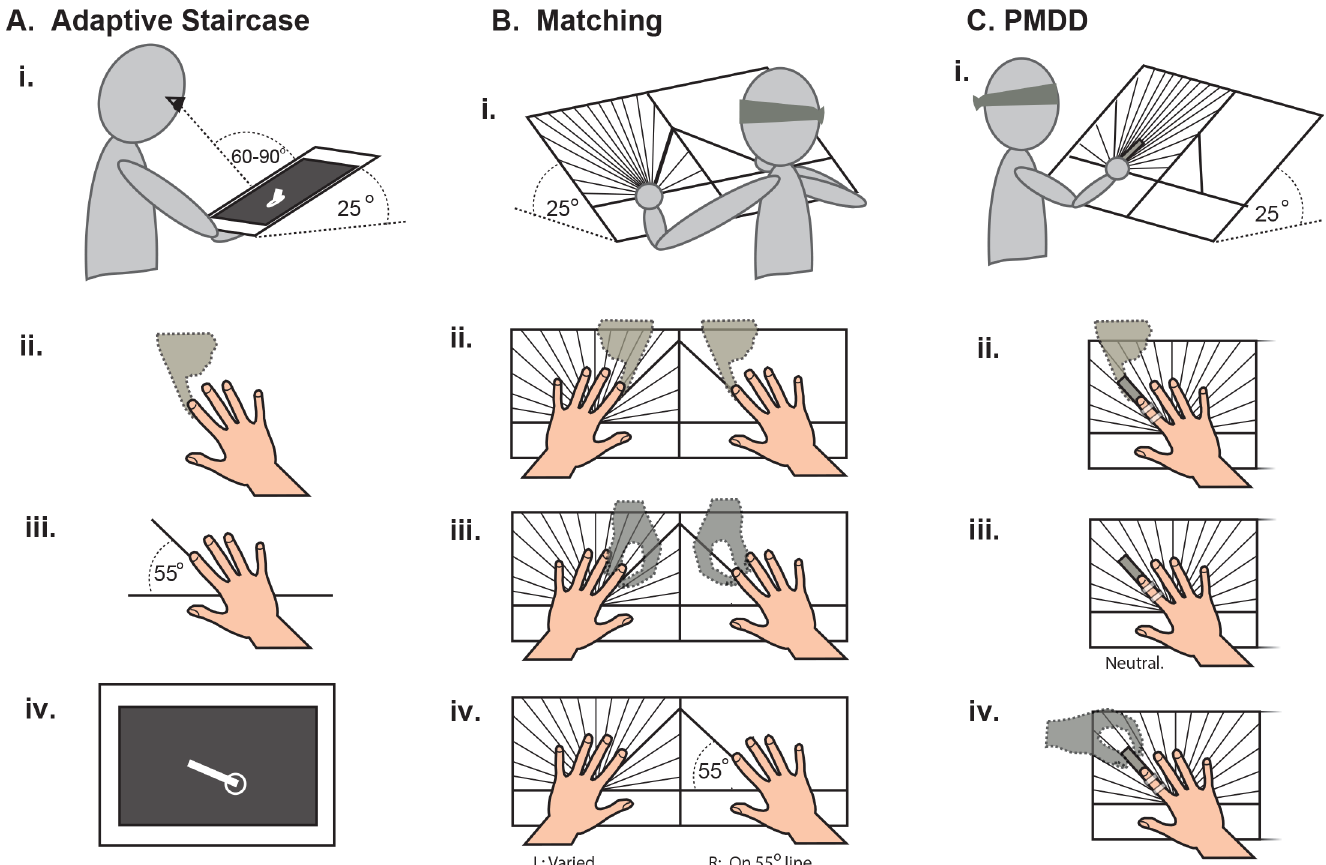
Fig 1. Setup procedures for each method. A. i . Subject positioning for the adaptive staircase method. Right hand placed on a 25° stand beneath the display screen. ii. The blindfolded subject was instructed to press firmly against the experimenter ’ s finger (dashed outline) and then relax to control for muscle thixotropy. iii. The hand was positioned in an outline drawn on the angled stand. The MP joint of the 2 nd finger was on a tactile marker with the index finger pointing along a 55° line and the other fingers slightly spread. iv. The display screen was placed over the subject ’ s hand and the blindfold removed. Subject was asked, “ Do you feel like the end of the white line is to the left or to the right of your index fingertip? ” B. i. Subject positioning for the matching method. Both hands placed in outlines on the angle board, inclined at 25°. Subject blindfolded throughout. ii. Controlling for muscle thixotropy in both index fingers. iii. The experimenter (dashed outlines) moved each index finger in turn with a variety of motions. iv. The experimenter placed the right index finger along the 55° line and the left in a variety of positions about the mirrored position. Subjects were instructed to “ Move your left index finger so it mirrors your right index finger. ” C. i. Subject positioning for the PMDD method. Right hand on the left half of the angle board, inclined at 25°. Index finger taped to a smooth stick. Subjects blindfolded throughout. ii. Controlling for muscle thixotropy. iii. Experimenter placed hand with fingers slightly spread and index finger in a neutral position. iv. Touching only the stick, experimenter moved subject ’ s index finger right or left (~0.062°/s) to a standard angular magnitude. Subject was asked, “ Did I move your finger to the left or to the right? ”